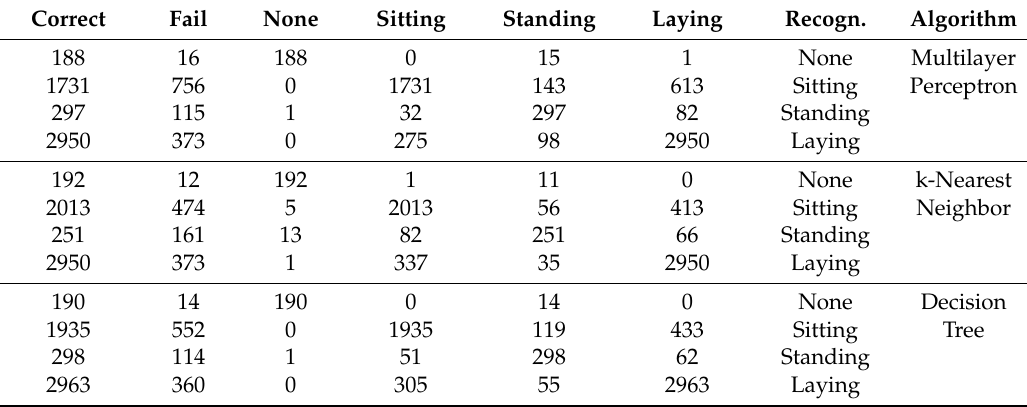
Table 7. Confusion matrix of posture classification by